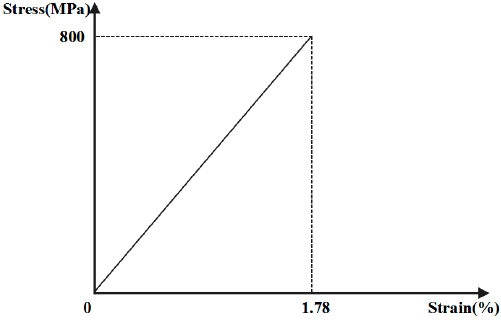
Figure 5. Constitutive relation of the FRP bolt.